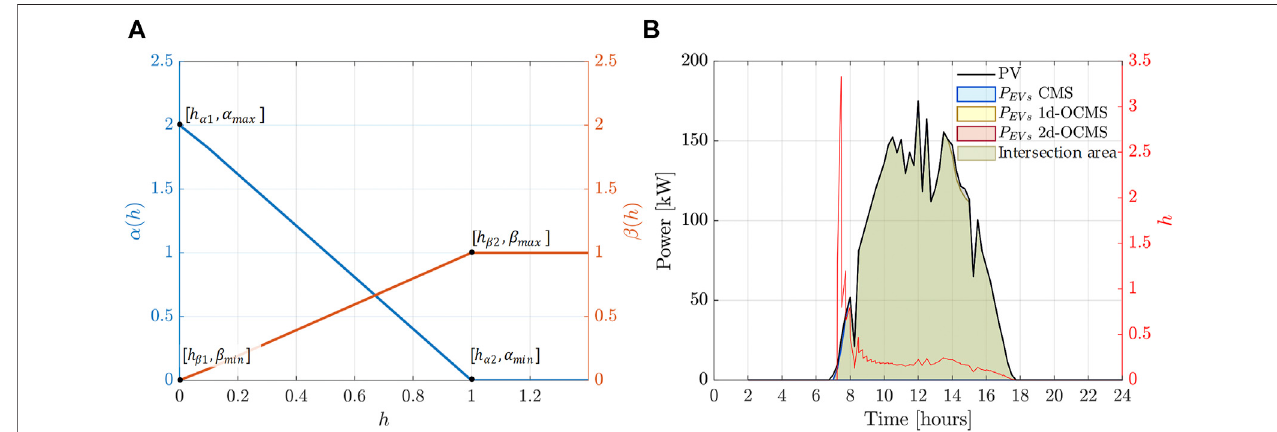
FIGURE 8 | (A) 1d-OCMS setting of the weighting factors α ( h ) and β ( h ) used in the simulations. (B) The daily evolution of h -factor (red line), PV (black line) power, and EVs charging power in case of standard CMS (light blue area), 1d-OCMS (yellow area), and 2d-OCMS (red area). The intersection area (displayed in green color) shows that there are no differences among the three CMSs in this case.